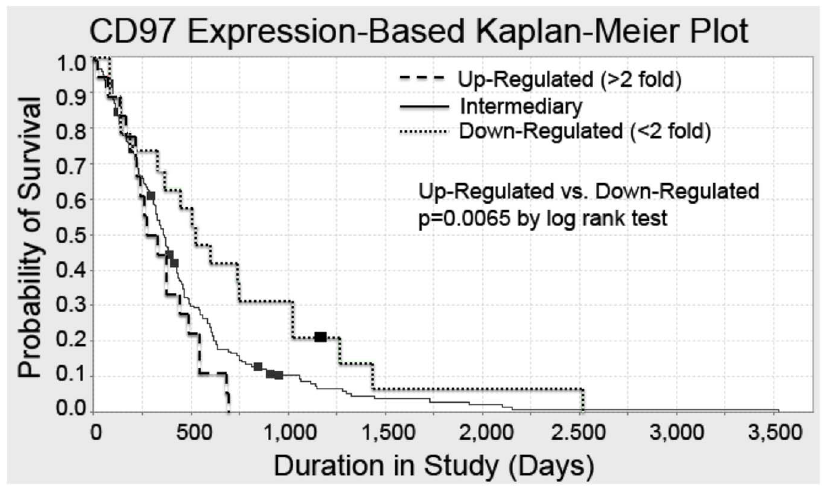
Figure 3. CD97 expression in GBM is inversely related to survival. Using The Cancer Genome Atlas database, we performed univariate analysis to assess a potential association between CD97 expression and overall survival. Tumors were classified as possessing intermediate expression, down-regulated expression, or up-regulated expression. Up-regulated tumors were defined as those with a greater than two-fold increase in CD97 transcript, while those with a greater than two-fold decrease were classified as down-regulated. When comparing overall survival among patients with tumors demonstrating up-regulation of CD97 to those with down-regulation of CD97, there was a significant difference in survival (p=0.0065) demonstrating an association between increased CD97 expression and decreased survival.